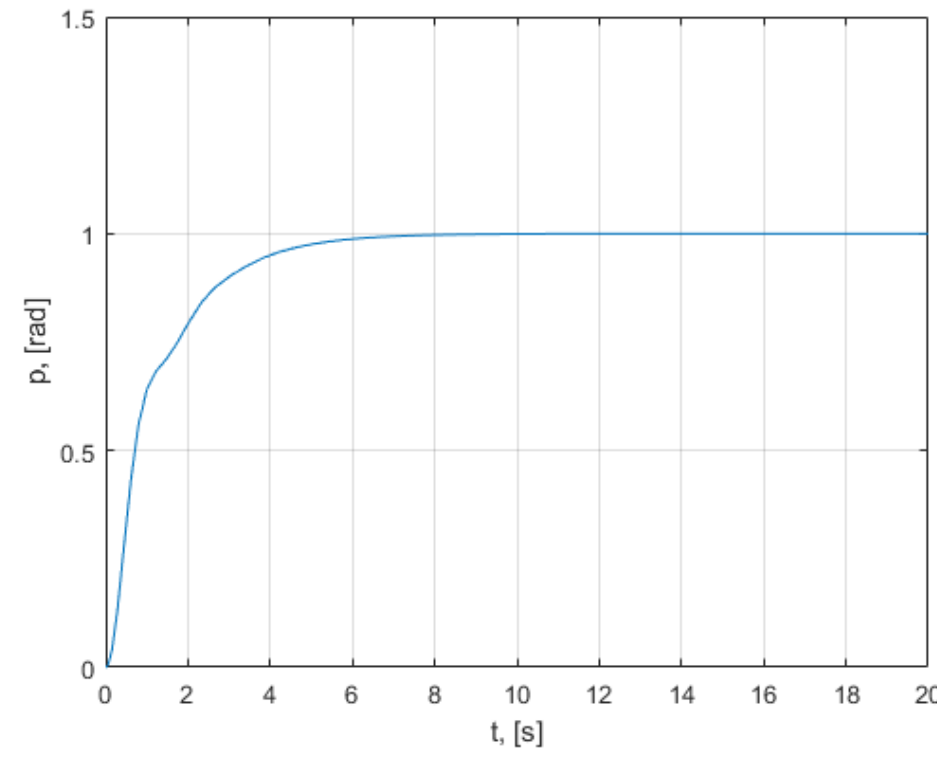
Figure A3. The step response of position control system.